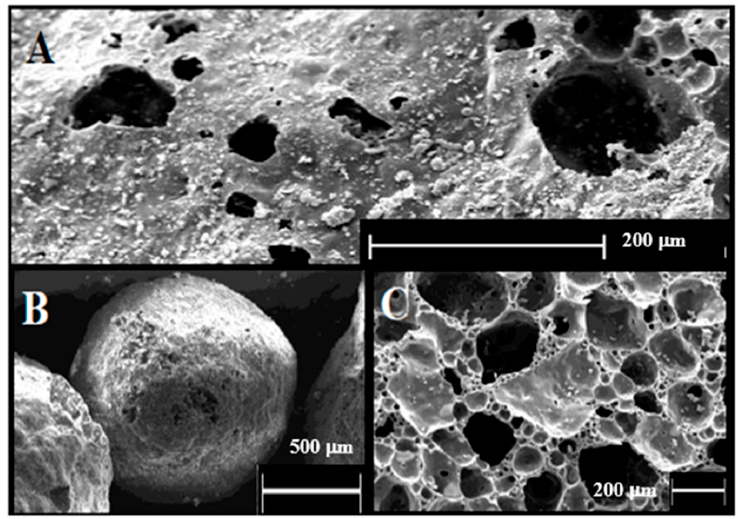
Figure 2. SEM back-scattered electron images of ( A ) the surface of a RWPG grain, of ( B ) a typical glass bead, and of ( C ) the internal texture of a